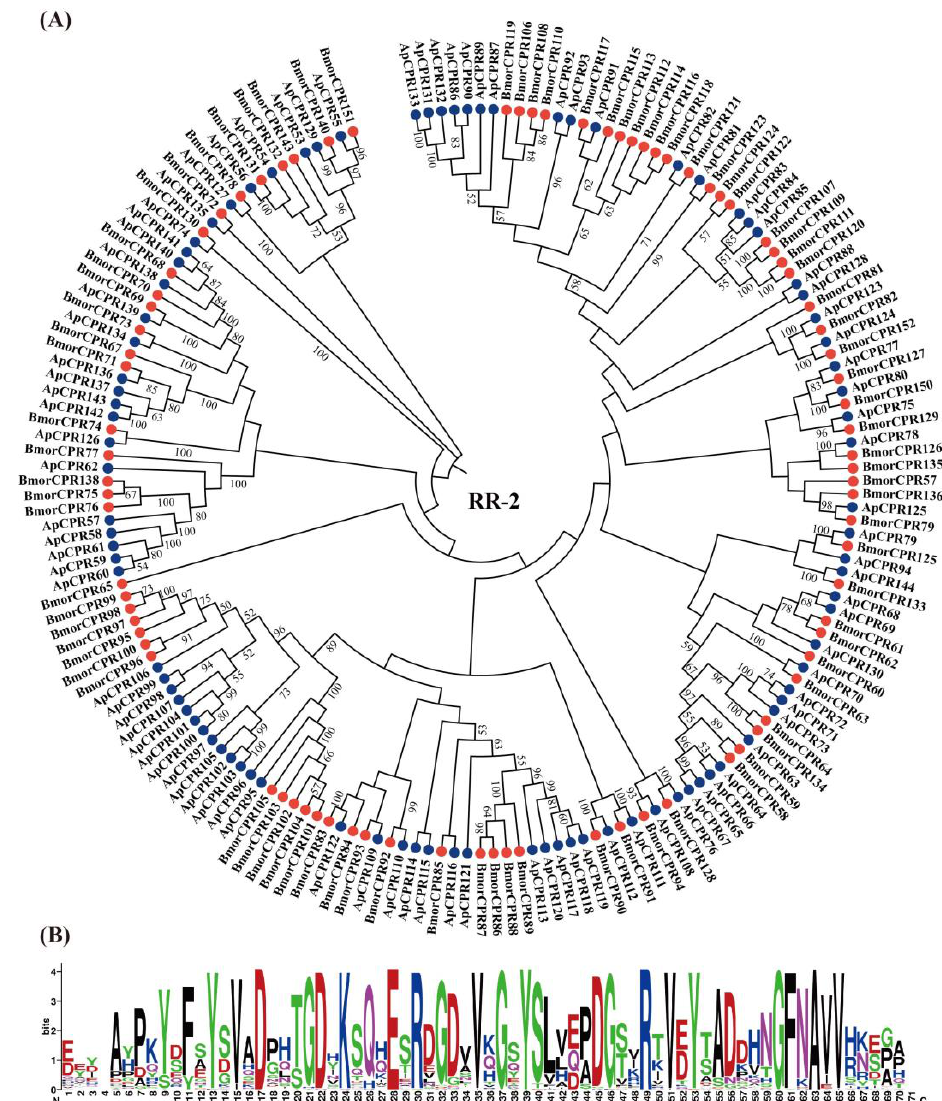
Figure 3. Phylogenetic relationship ( A ) and sequence logo of the conserved region ( B ) of RR-2 proteins from A. pernyi (Ap; blue circle) and B. mori (Bmor; red circle). The sequence logo was generated by Weblogo [34].